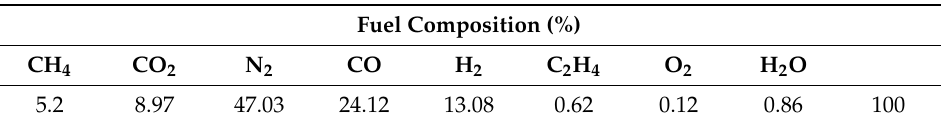
Table 1. Composition of the fuel.